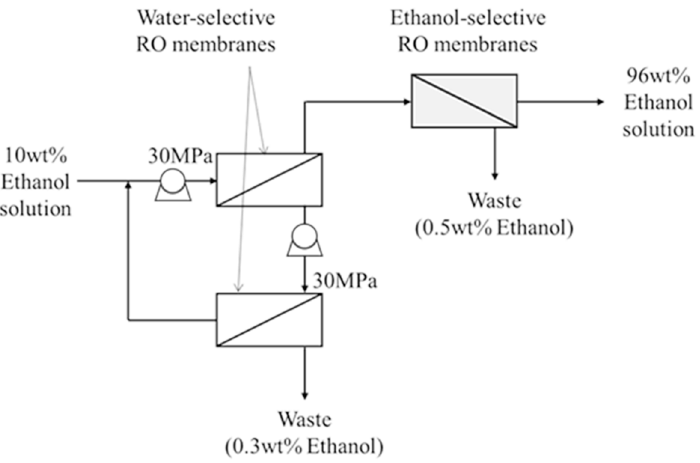
Figure 4. Example of combining two types of RO membranes (modified from [51]).